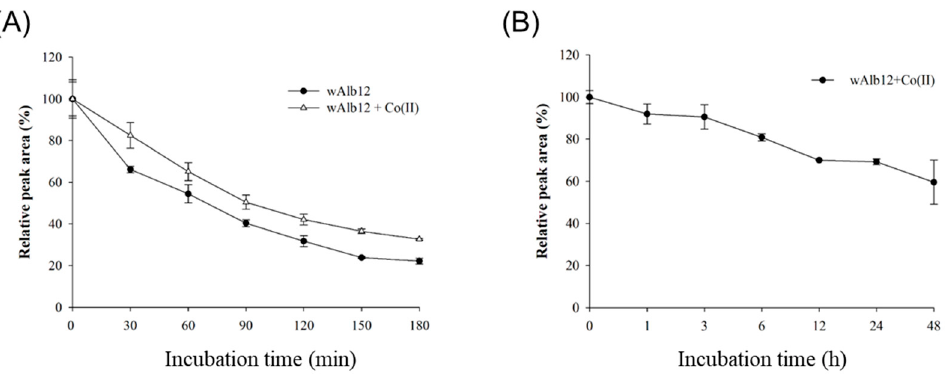
Figure 7. Stability of wAlb12+Co(II). Proteolytic stability of wAlb12 and wAlb12 + Co(II) complex ( A ) and human serum stability of wAlb12+Co(II) complex in vitro ( B ).